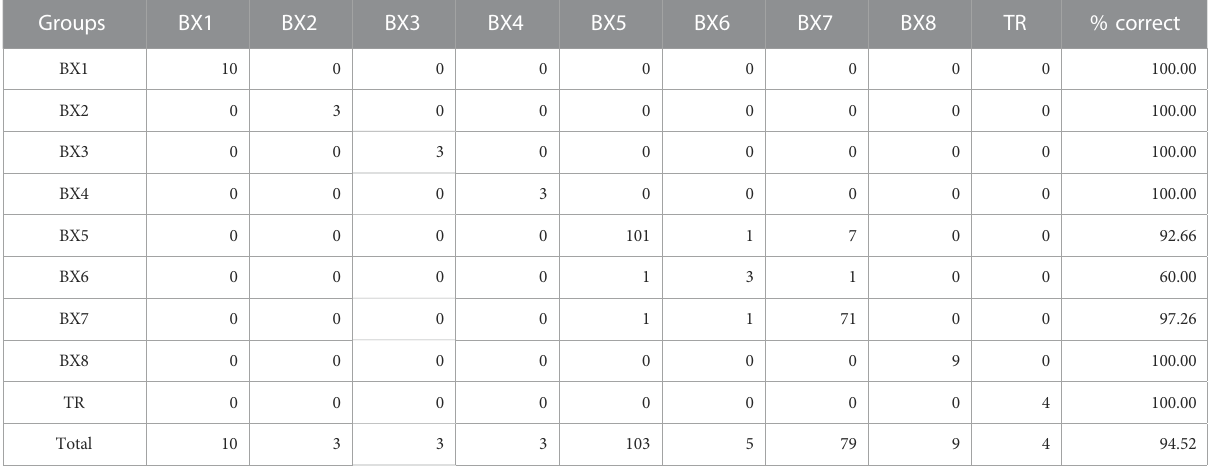
TABLE 3 Classi fi cation matrix. Groups